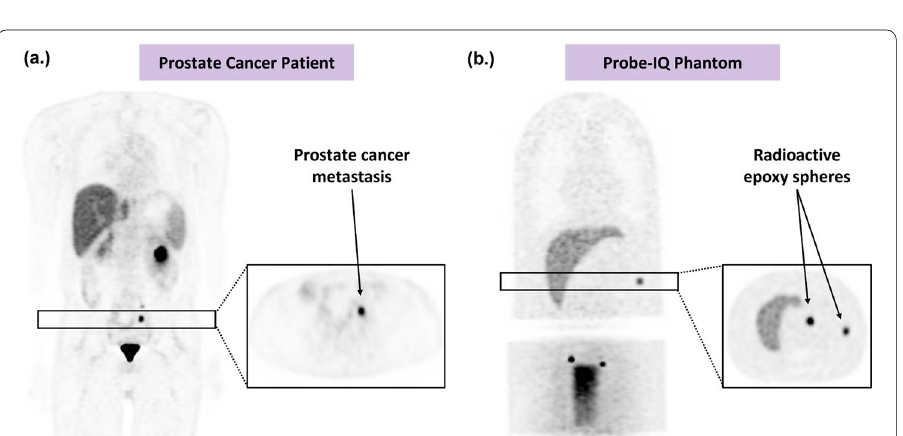
Fig. 4 PET images comparing real and simulated lesions in PSMA patient and Probe-IQ phantom, respectively. a PSMA PET image of patient with prostate cancer metastasis. b PET image of Probe-IQ phantom with embedded radioactive epoxy spheres. Transaxial slices are shown to highlight the realism of the simulated